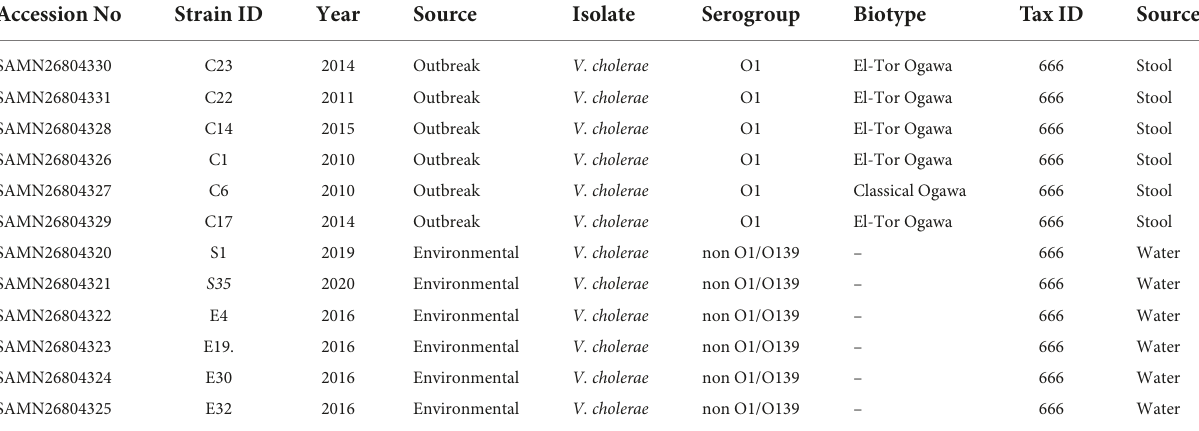
TABLE 1 Description of the Vibrio cholerae isolates obtained from stool and water